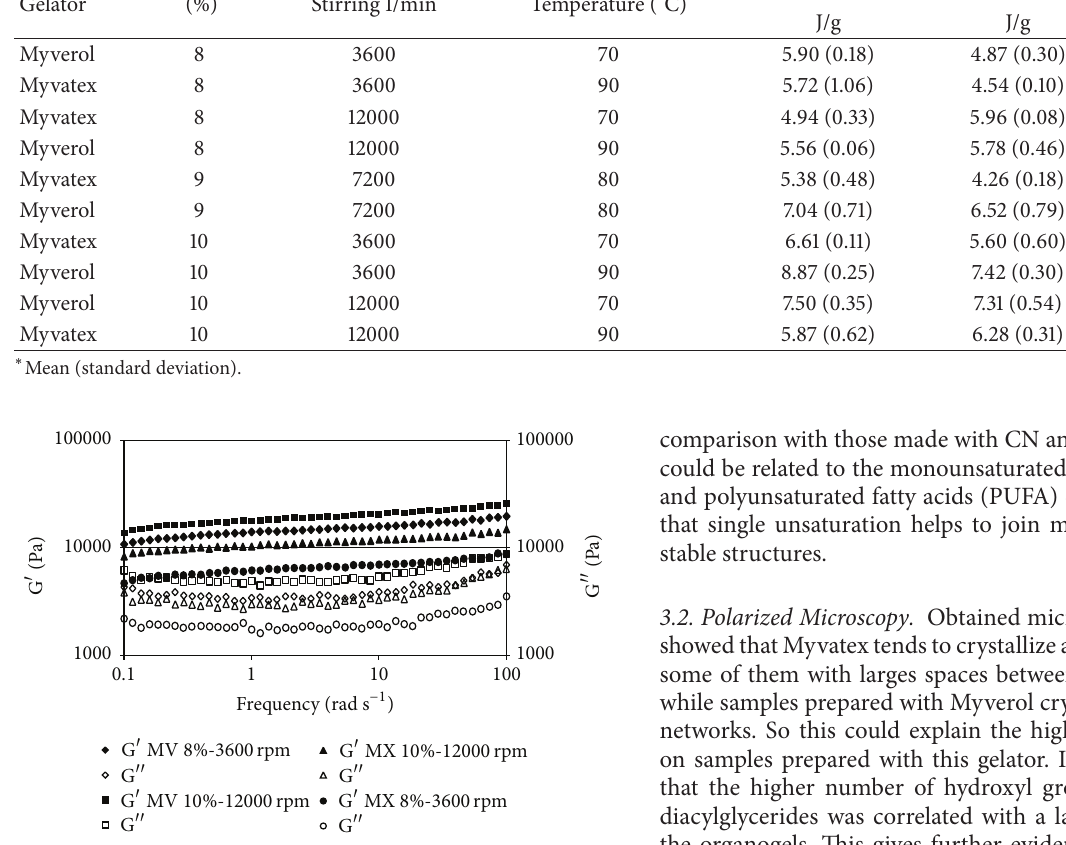
Figure 3: Frequency sweep comparison of soy oil samples. 𝐺 󸀠 module (filled), 𝐺 󸀠󸀠 module (empty). Gelators used: Myverol (MV) and Myvatex